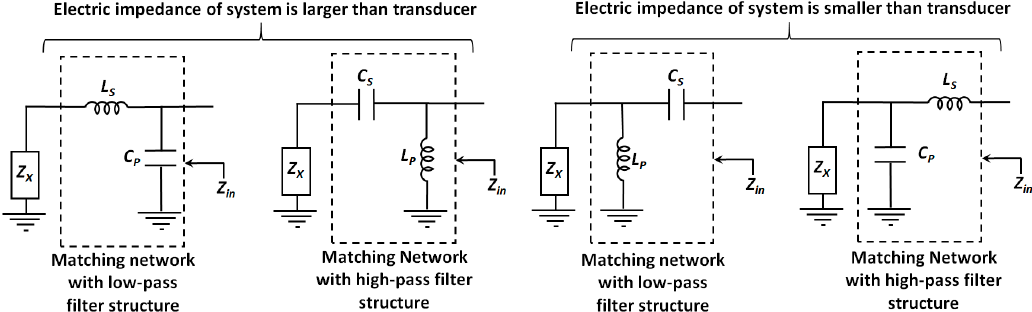
Figure 9. Schematic circuitry of the EIMN in the case where the electrical impedance magnitude of a system is larger than that of a transducer based on Low-pass (left) and high-pass (right) filter structures. 𝐿 (cid:3046) and 𝐿 (cid:3043) indicate series and parallel inductors and 𝐶 (cid:3046) and 𝐶 (cid:3043) are series and parallel capacitors